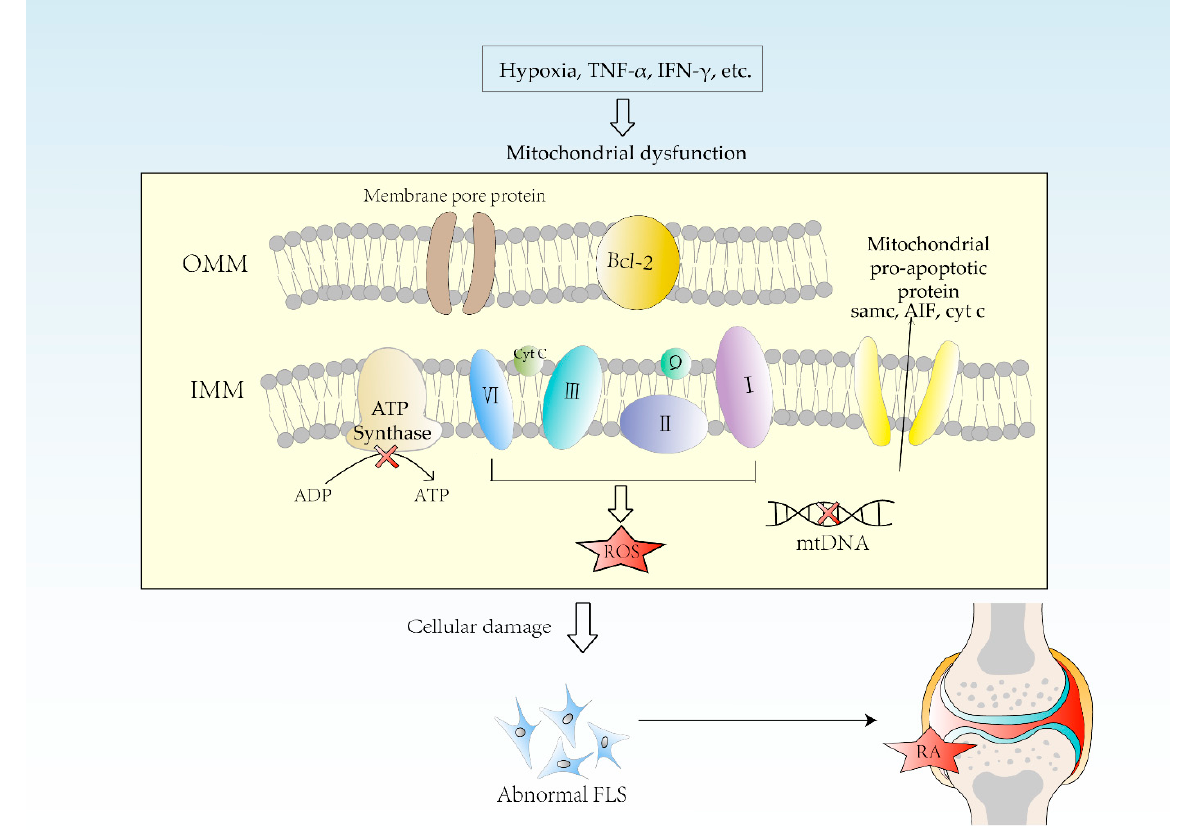
Figure 3. Etiology of mitochondrial dysfunction in RA. Hypoxia causes multiple changes in mito- chondrial structure, genome, and dynamics, resulting in decreased ATP synthesis, excessive ROS production, and increased accumulation of mtDNA mutations. The more TNF- α and IFN- γ in syn- ovium, the higher the frequency of mtDNA mutation. Mitochondrial dysfunction leads to cellular damage, including lots of inflammation reactions, which causes RA. FLS = fibroblast-like synovio- cytes, OMM = outer mitochondrial membrane, IMM = inner mitochondrial membrane. Smac = second mitochondrial-derived activator of caspases, AIF = apoptosis-inducing factor, Cyt. c = cytochrome c. The inflammatory environment can promote mtDNA mutations. L. C. Harty et